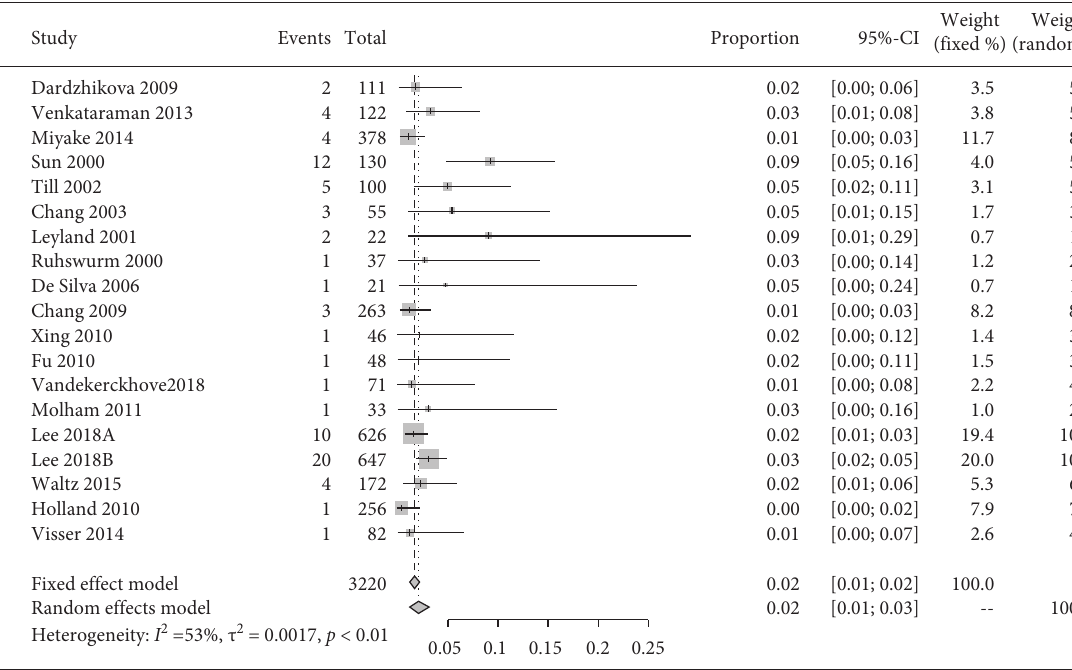
Figure 2: The forest plot displaying the pooled incidence rate of repositioning surgery of toric